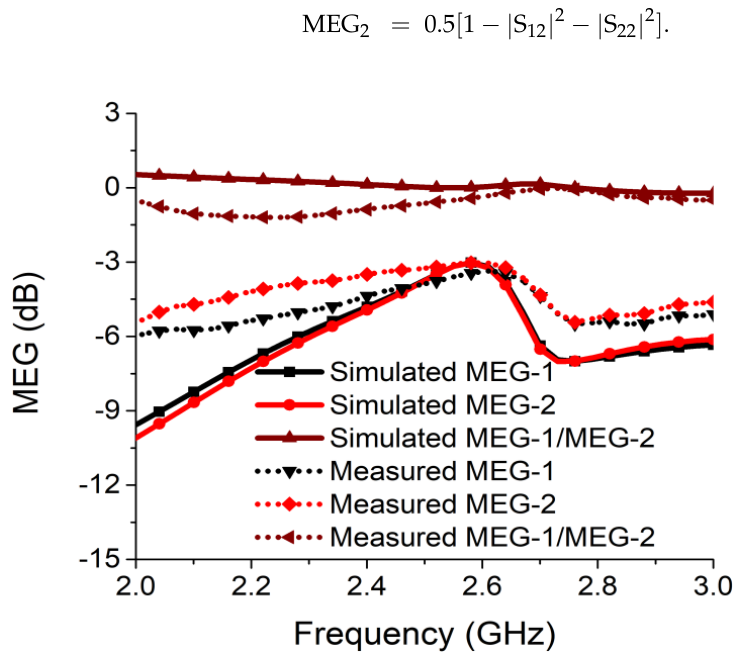
Figure 20. Mean effective gain (MEG) of proposed two-port MIMO antenna.